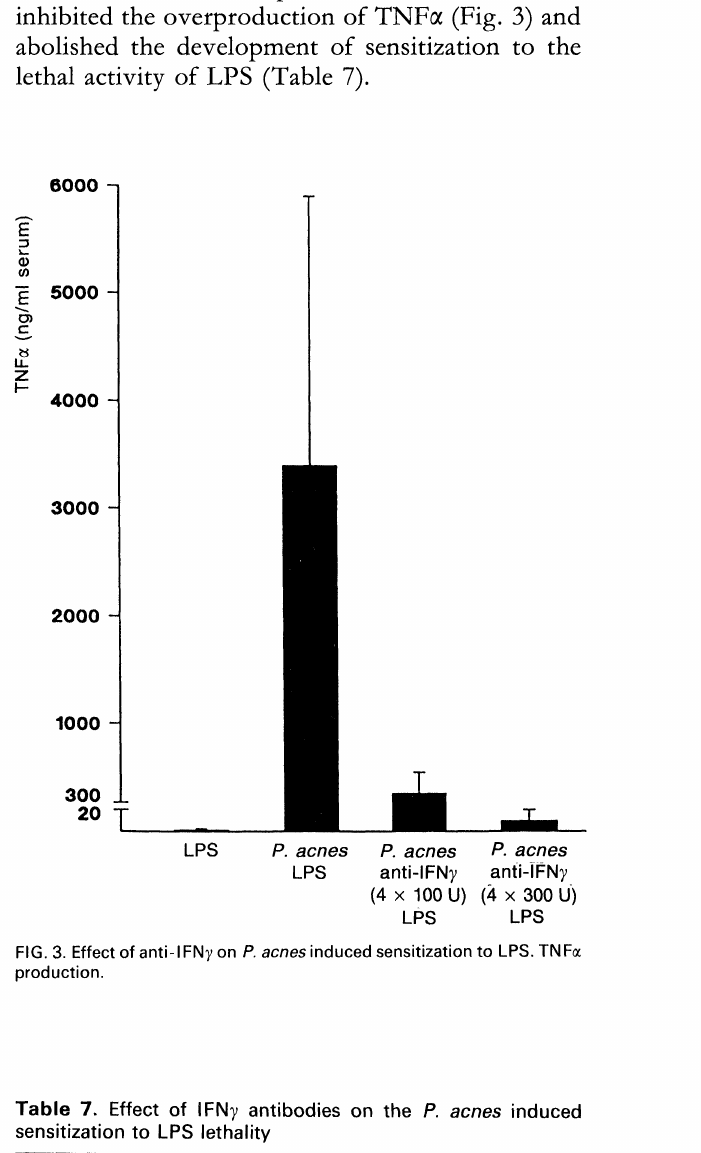
Table 6. Effect of treatment with bacteria on the sensitivity of mice to the lethal activity of human rTNF Treatment